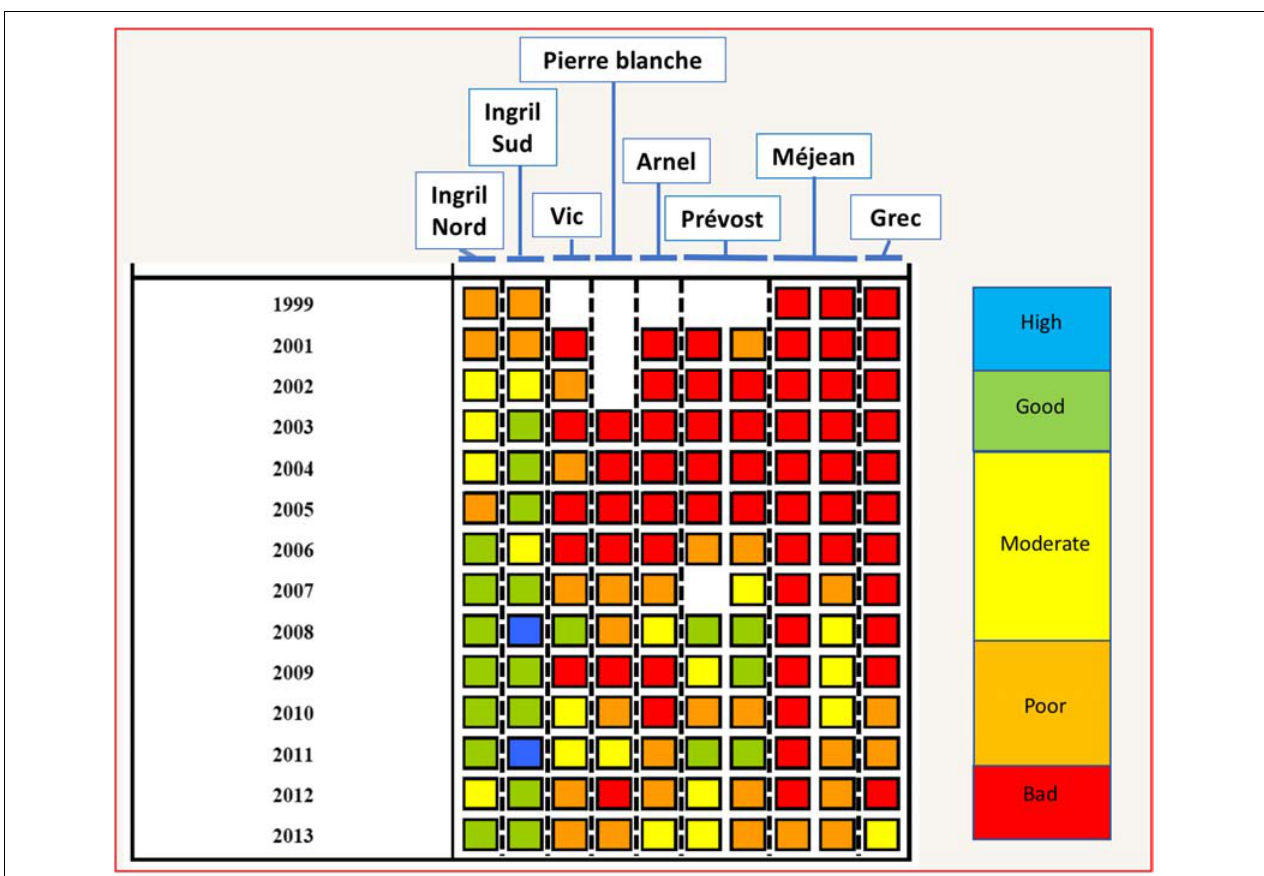
FIGURE 8 | Color coding restitution of water quality by the Lagoon Monitoring Network for the lagoons of the PLC from 1999–2013 (Figure designed using Tableau 11.2, page 175 of IFREMER, 2014, Courtesy Ifremer).